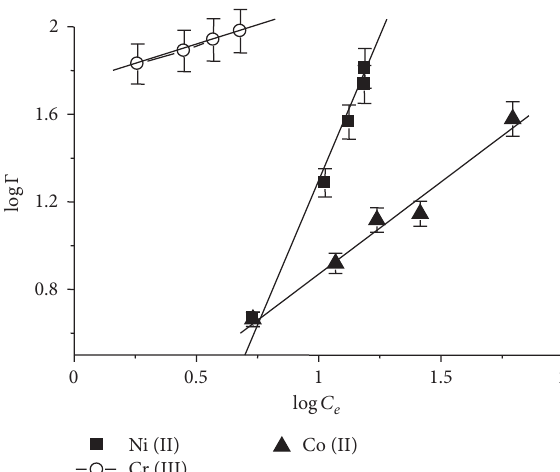
F 5: Freundlich isotherm for the biosorption of Ni(II), Cr(III), and Co(II) using Acalypha hispida